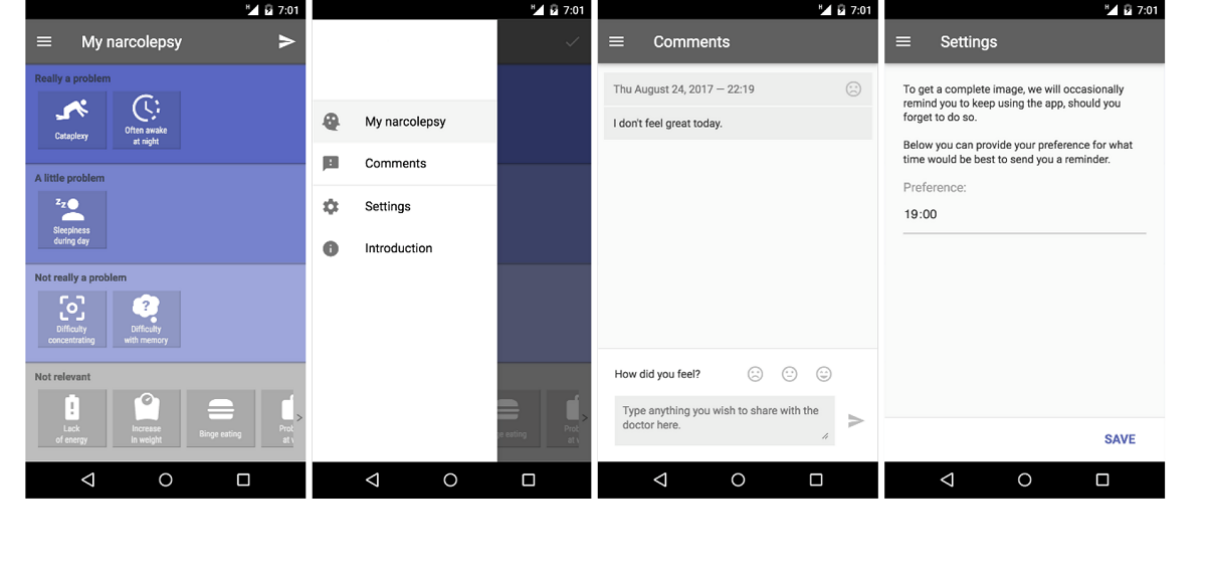
Figure 3. Final design of the Narcolepsy Monitor. The first panel shows the ranking environment in which patients list the narcolepsy symptom according to the subjectively experienced severity. The second panel shows the menu in which one can choose to navigate to the ranking screen, the comment section, personal settings and the introduction. In the third panel the possibility to add comments is shown. The last panel shows the possibility to adjust the time for the reminder to use the